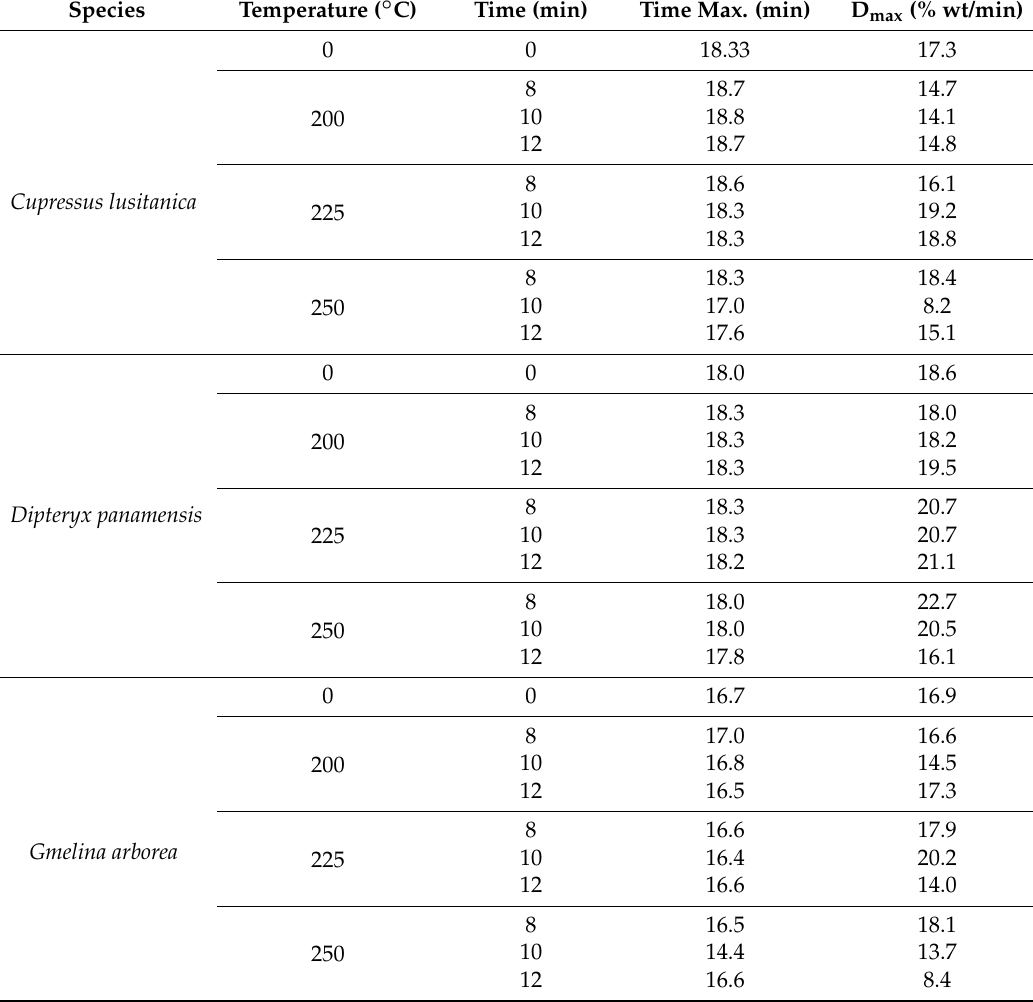
Table 5. Time to reach the maximum devolatilization rate determined by thermogravimetric analysis (TGA) experiments of the biomasses of five fast-growth plantation species in Costa Rica torrefied at different times and temperatures. Species Temperature ( ◦ C) Time (min) Time Max. (min) D max (% wt/min) 0 0